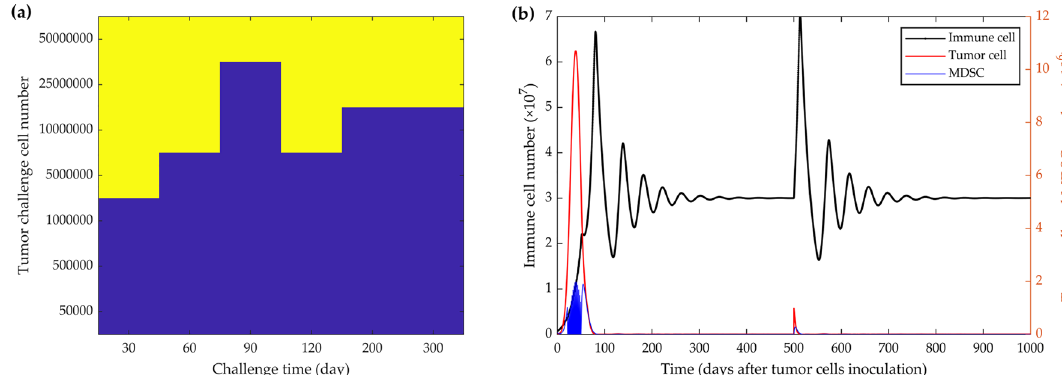
Figure 6. Simulation of the preconditioning effect of proliferative tumor cells in combination with MDSC- depletion on the tumor challenge fate. According to the challenge size and time, the stimulation of an immune response, with 5 × 10 3 tumor cells inoculation and depletion of MDSCs every 48 h from day 21 for 1 month, prevent tumor cell challenges from generating tumors for several years ( a ). Color-coded events: blue, dormancy; yellow, tumor growth. Preconditioning with 5 × 10 3 tumor cell inoculation and depletion of MDSCs every 48 h from day 21 for 1-month duration resulted in long-term immunity and growth control of 1 million tumoral challenging cells injected 500 days after the initial (preconditioning) tumor cells injection ( b ). The left y-axis represents the number of immune cells, and the right y-axis the number of MDSCs (blue curve) and tumor cells (red